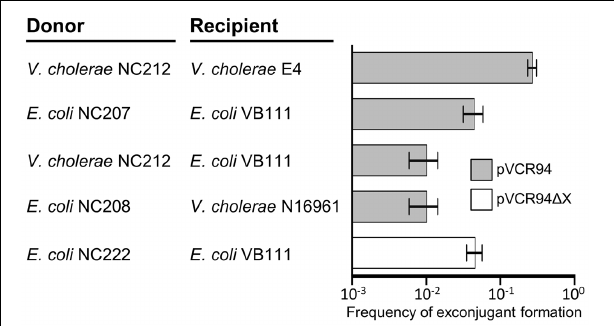
variable region VR1 contains DNA that is only found in